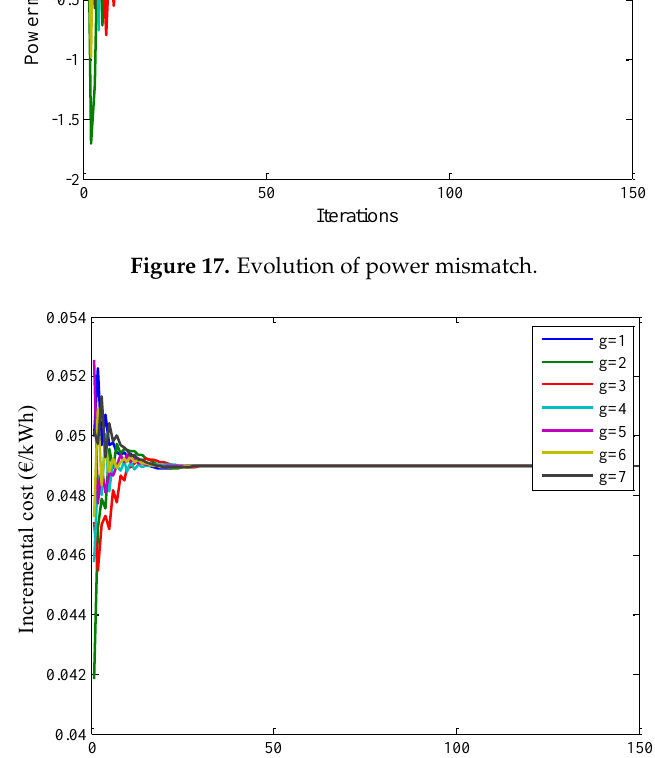
Figure 18. Evolution of incremental